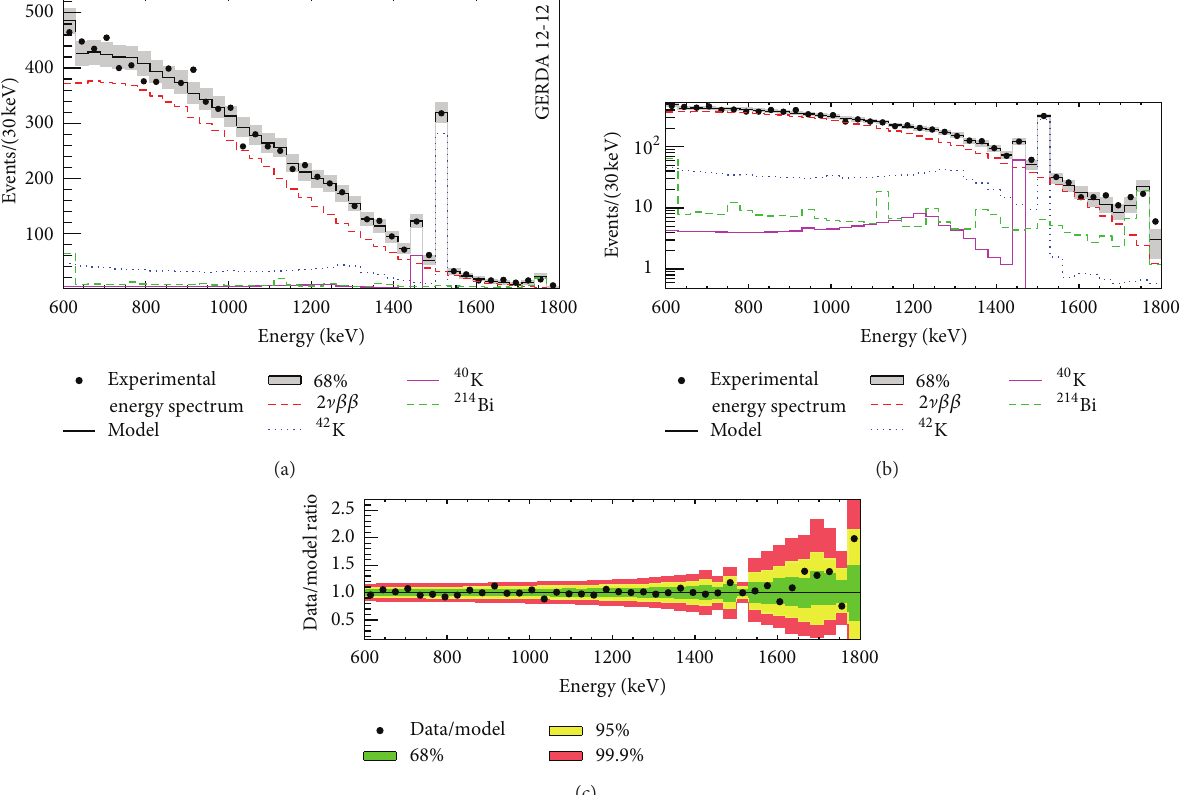
Figure 3: (a) shows the experimental data (black markers) and the best fit model (black histogram) for the sum of the semicoaxial detectors in linear scale and (b) in logarithmic scale. Individual components are shown with colored histograms. The shaded band covers the 68% probability range for the model expectation. (c) gives the ratio between experimental data and theprediction of thebest fit model. The smallest intervals containing the 68%, 95%, and 99.9% probability for the expectation are shown in green, yellow, and red regions, respectively. From